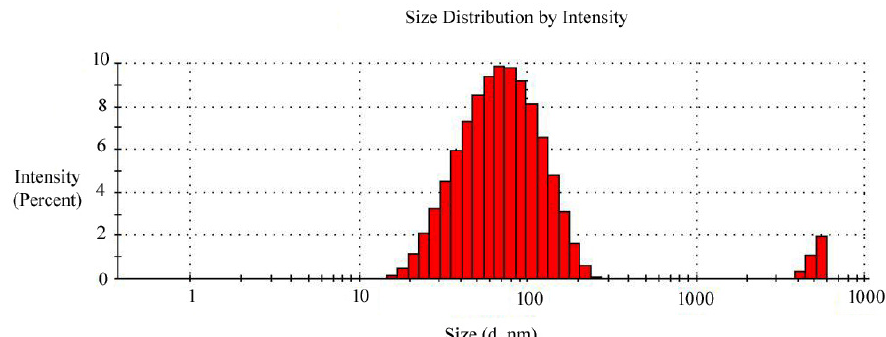
Fig. 7. DLS size distribution by intensity of G. applanatum extract mediate SNPs